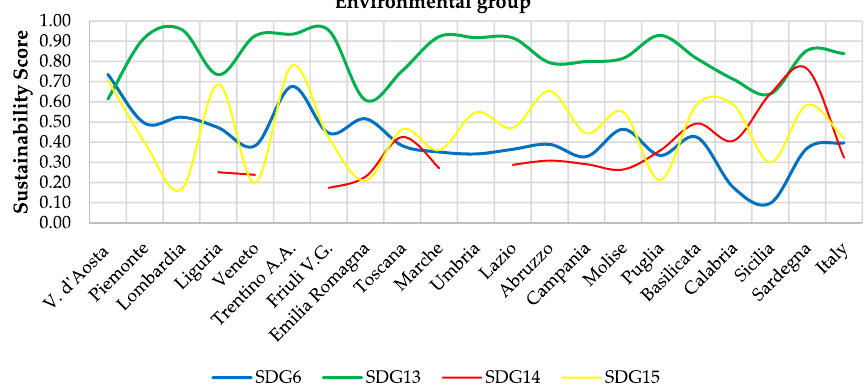
Figure 4. Sustainability Score in EWG scenario—environmental group.